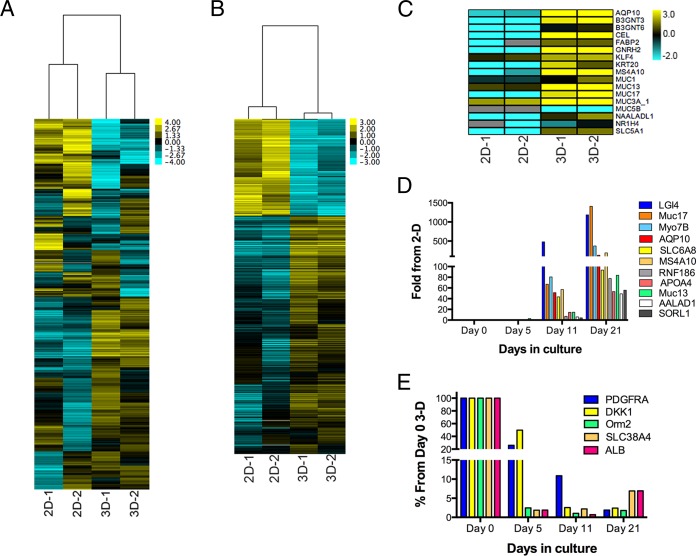
(A) Hierarchical clustering heat map of genes expressed in 2-D or 3-D cultures of Caco-2 cells as determined by RNA-Seq. (B) Hierarchical clustering heat map of genes differentially expressed (P < 0.001) in 2-D or 3-D cultures of Caco-2 cells as determined by RNA-Seq, followed by DeSeq2 analysis. (C) Heat map of select markers of intestinal differentiation and/or intestine-specific processes in 2-D or 3-D cultures of Caco-2 cells. The intensity of the color in panels A to C indicates the level of gene expression (yellow for upregulation and blue for downregulation), and gray indicates that no RNA-seq reads were detected for that transcript in that sample. RNA-Seq was performed on two independent 2-D cultures (2D-1 and 2D-2) and two independent 3-D STLVs (3D-1 and 3D-2). (D and E) RT-qPCR analysis of genes upregulated (D) or downregulated (E) in 3-D cultures of Caco-2 cells. In panel D, data are shown as the fold change in the expression of the indicated genes relative to the level of expression in 2-D controls at the indicated days postculturing in 3-D. In panel E, data are shown as the percent change in the expression of the indicated genes relative to the levels at day 0 of the 3-D culture period.